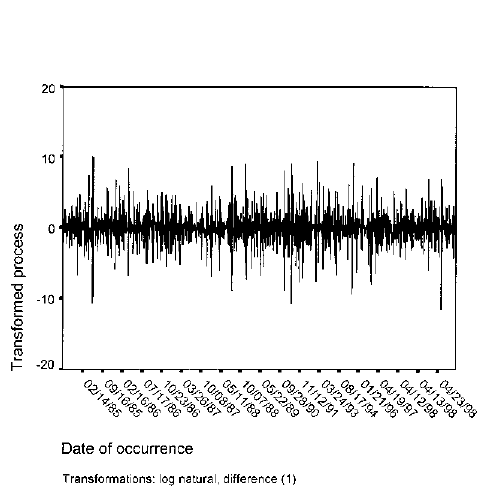
Fig. 6. Sequence graph of transformed process { y